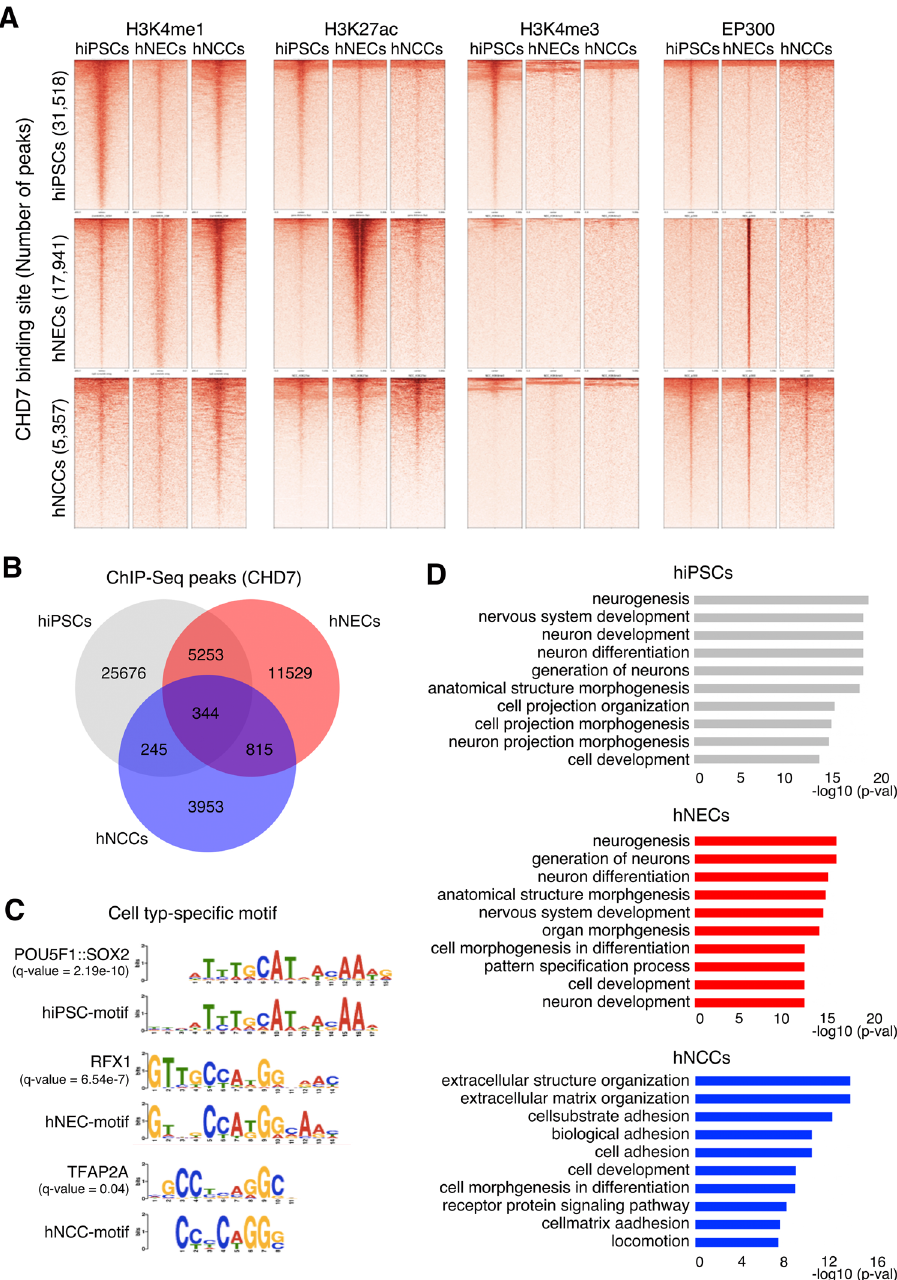
Figure 2. Cell type-specific functions of CHD7. ( A ) Heatmap analyses of ChIP-seq signal of EP300 and selected histone modifications in hiPSCs, hNECs, and hNCCs (H3K4me1, H3K4me3, and H3K27ac). Read counts were extracted for all ChIP-seq experiments within a region spanning ± 5 kb around the center of each annotated CHD7-peaks detected in each cell type (1st row: 31,518 peaks in hiPSCs, 2nd row: 17,941 peaks in hNECs and 3rd row: 5357 peaks in hNCCs). ( B ) Overlaps of CHD7-binding regions across different cell types. ( C ) Cell type-specific CHD7-binding sequences were analyzed using the top 500 binding regions of CHD7- ChIP-seq data. The detected sequences were compared using the JASPAR motif database. ( D ) GO analysis for biological processes associated with CHD7-bound regions in hiPSCs, hNECs, and hNCCs. Bar plots displaying the top 10 GO